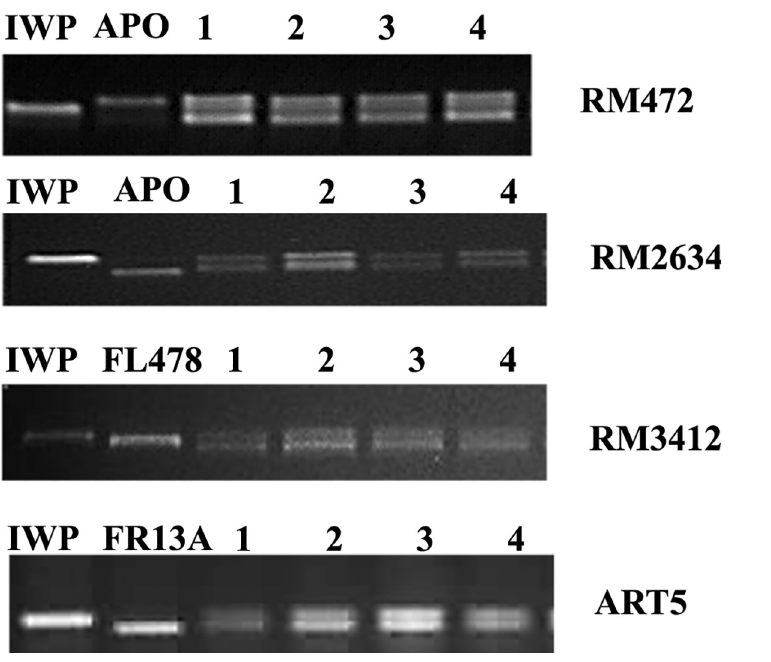
Fig 3. Foreground selection of BC 1 F 1 progenies using markers linked to target traits.